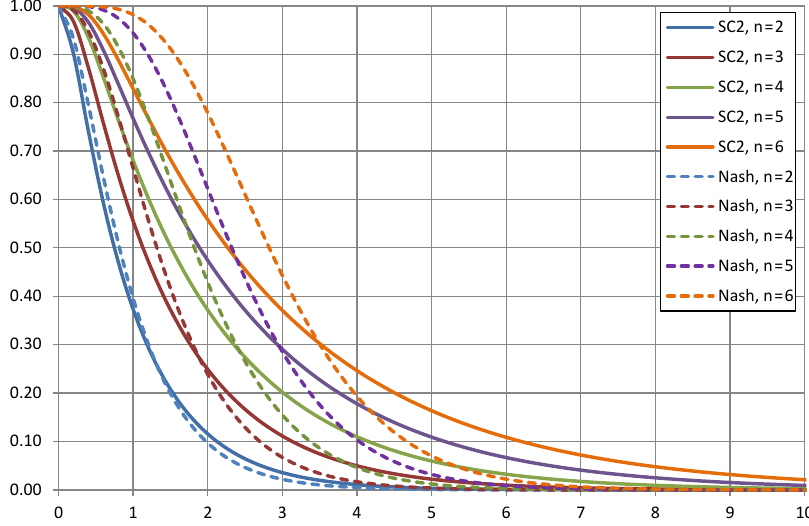
Figure 9. Comparison of recession curves in SC2 and Nash models ( k SC2 = n ).